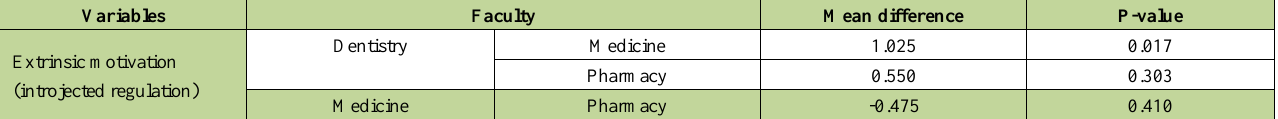
Table 4. Comparison of mean scores of motivation subscale and academic motivation scale based on the faculties of dentistry, medicine, and Faculties/